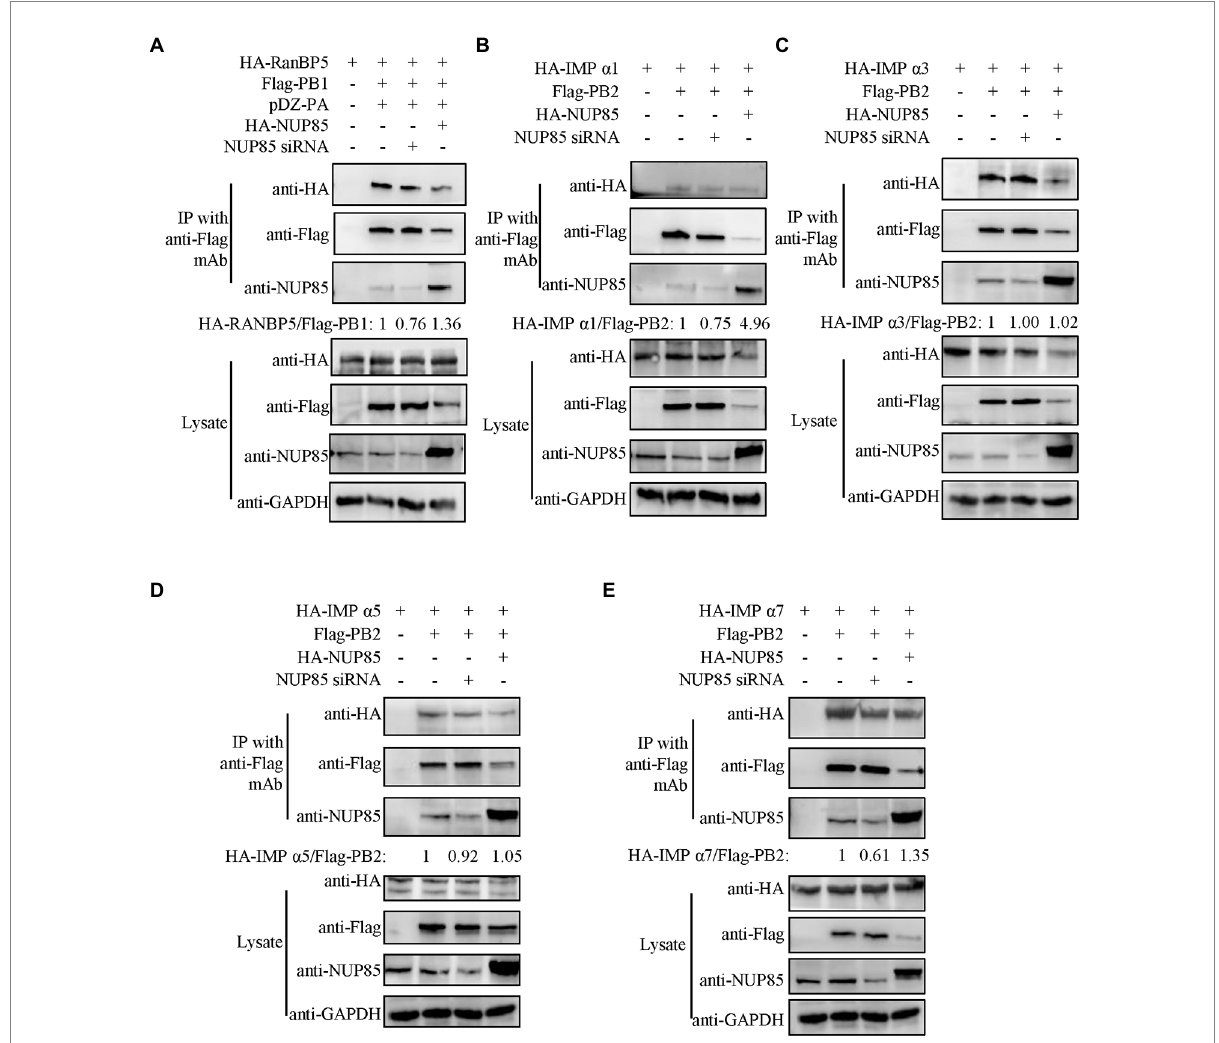
FIGURE 6 NUP85 facilitates IAV PB1-RanBP5, PB2-importin α 1, and PB2-importin α 7 interactions. (A) Effect of NUP85 on the interaction between RanBP5 in PB1. HEK293T cells were treated with NUP85 siRNA or NUP85 expressing plasmids and then transfected with the indicated plasmids for 24 h. Cell lysates were immunoprecipitated with an anti-Flag antibody. RanBP5 and Flag-PB1 levels were detected via Western blot. The band intensities were quantified by ImageJ, and relative precipitated HA-RanBP5 /Flag-PB1 ratios are shown at the bottom. (B–E) Interaction of PB2 with importin α family members, importin α 1 (B) , importin α 3 (C) , importin α 5 (D) , and importin α 7 (E) in the NUP85 siRNA or NUP85 expressing plasmid treated cells. Cell lysates were immunoprecipitated with a mouse anti-Flag antibody. The bound proteins were detected by Western blot with a rabbit anti-HA antibody, a mouse anti-Flag antibody, or a rabbit anti-NUP85 antibody to detect importin α family members, NP, NUP85, and GAPDH, respectively. Images are representative of three independent experiments. The band intensities were quantified by ImageJ. The binding ratio